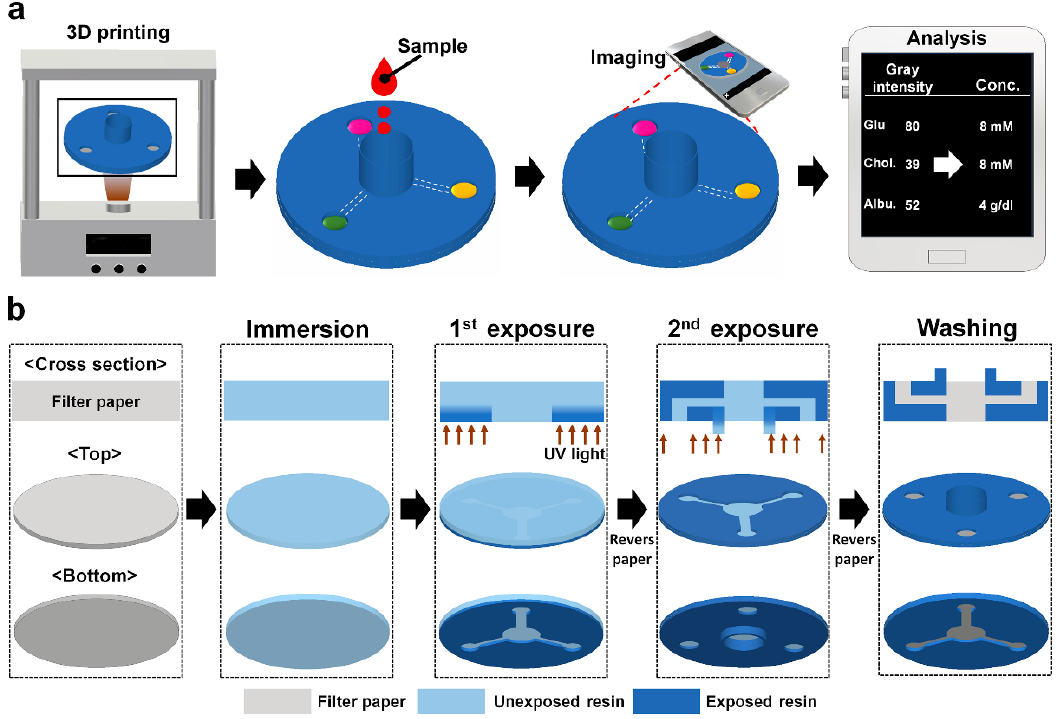
Figure 1. Schematics describing ( a ) smartphone-based colorimetric detection for multiple biomarkers on the 3D- µ PADs and ( b ) 3D DLP printer-based fabrication of the 3D- µ PADs.